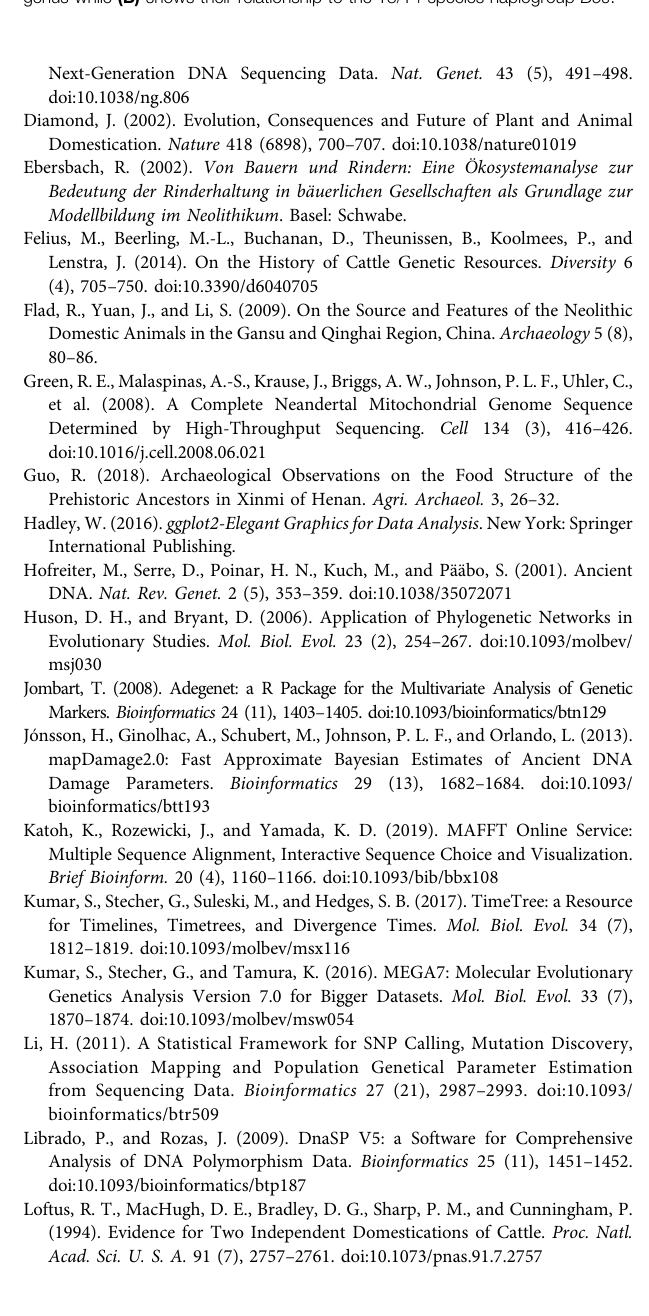
Supplementary Figure S2 | The DNA damage patterns of the ancient samples. Misincorporationsfrequenciesarerepresentedbythe fi rstand last 25nucleotides of reads aligned to the bovine mitochondrial reference genome V00654.